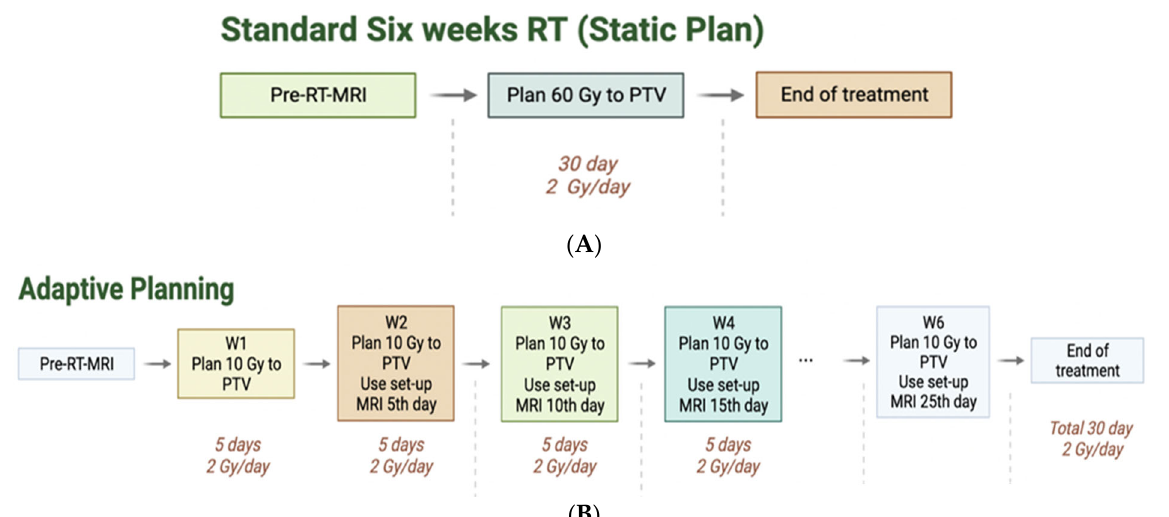
Figure 2. ( A ): Flow chart for static plan (60 Gy prescription to the PTV). ( B ): Flow chart for Adaptive planning (10 Gy prescription to the PTV with a total of 6 different plans and accumulated dose of 60 Gy). W1–W6 stands for Week 1–Week 6 of RT.